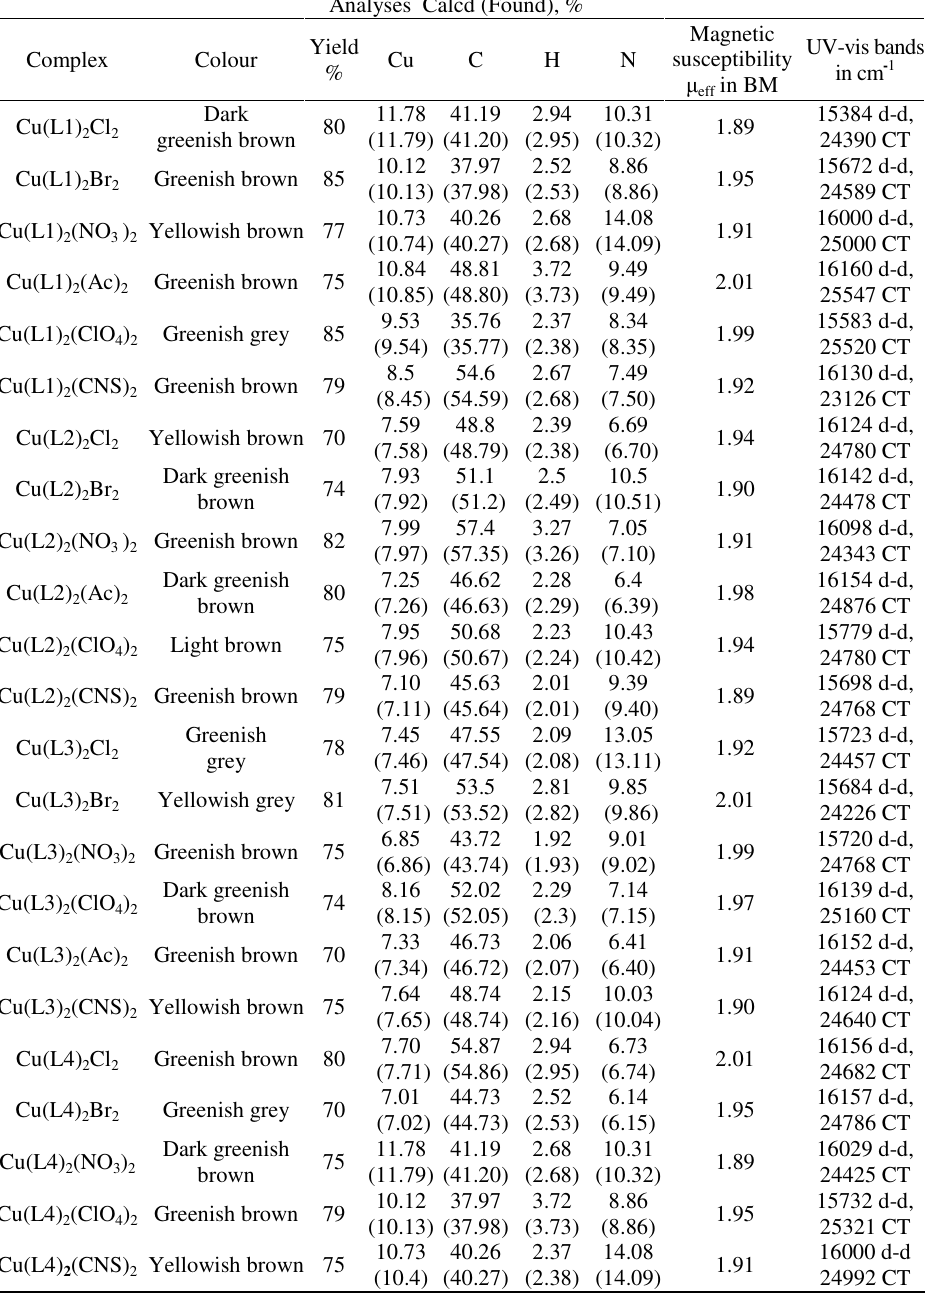
Table 1. Analytical, magnetic and electronic spectral data of Cu(II) chromen-2-one-3- carboxy hydrazides and